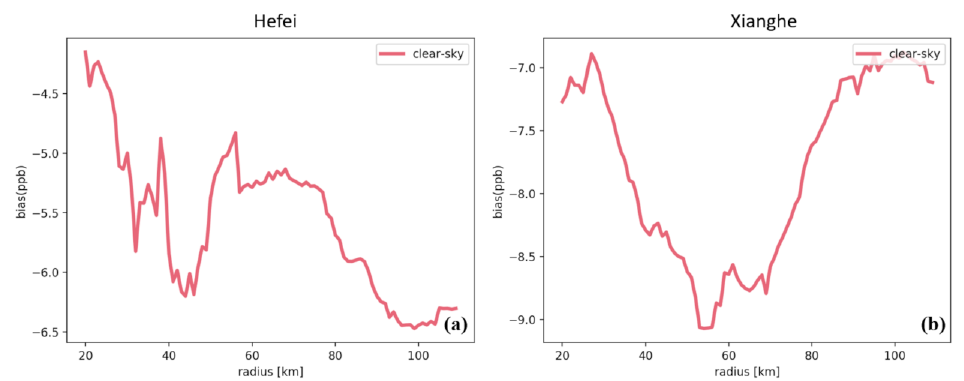
Figure 4. ( a ) The bias of XCH 4 between the TROPOMI data and the FTIR data (TROPOMI–FTIR) as function of the coincident radius around the Hefei site only for clear-sky satellite observations. ( b ) The same as ( a ) but for the Xianghe